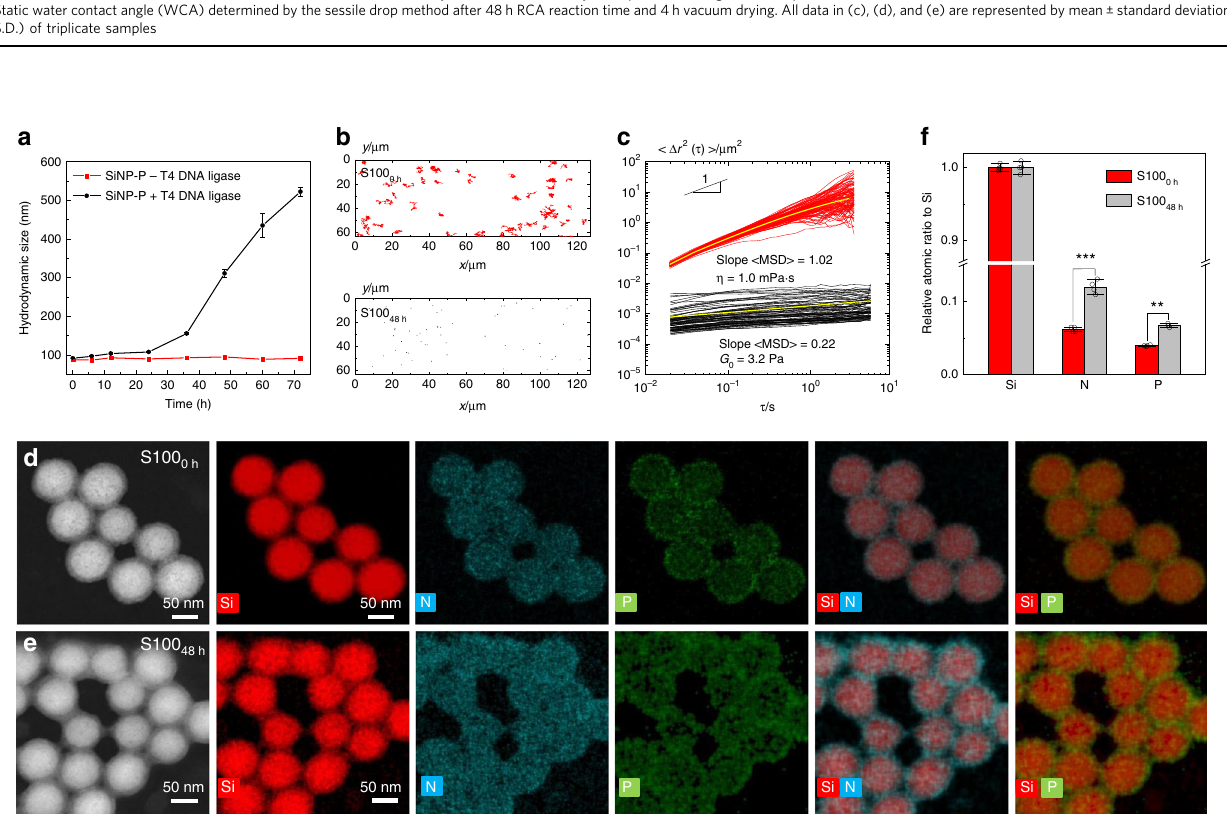
Fig. 3 Characterization of SiNP-DNA nanocomposites. a Hydrodynamic size of products produced from RCA on SiNP-primer-template (SiNP-P-T) particles in the presence or absence of T4 DNA ligase. All data are represented by mean ± S.D. of triplicate samples. b Trajectory maps and c MSD values of tracer particles in S100 after 0 and 48 h of RCA. The yellow curves in c represent the average MSD. d , e Representative HAADF-STEM imaging ( fi rst column), EDS elemental mapping (second to sixth column) and f relative atomic ratios of N and P to Si of S100 after 0 and 48 h of RCA. Data represent mean ± S.D. of the EDS measurements determined from 50 particles in four random